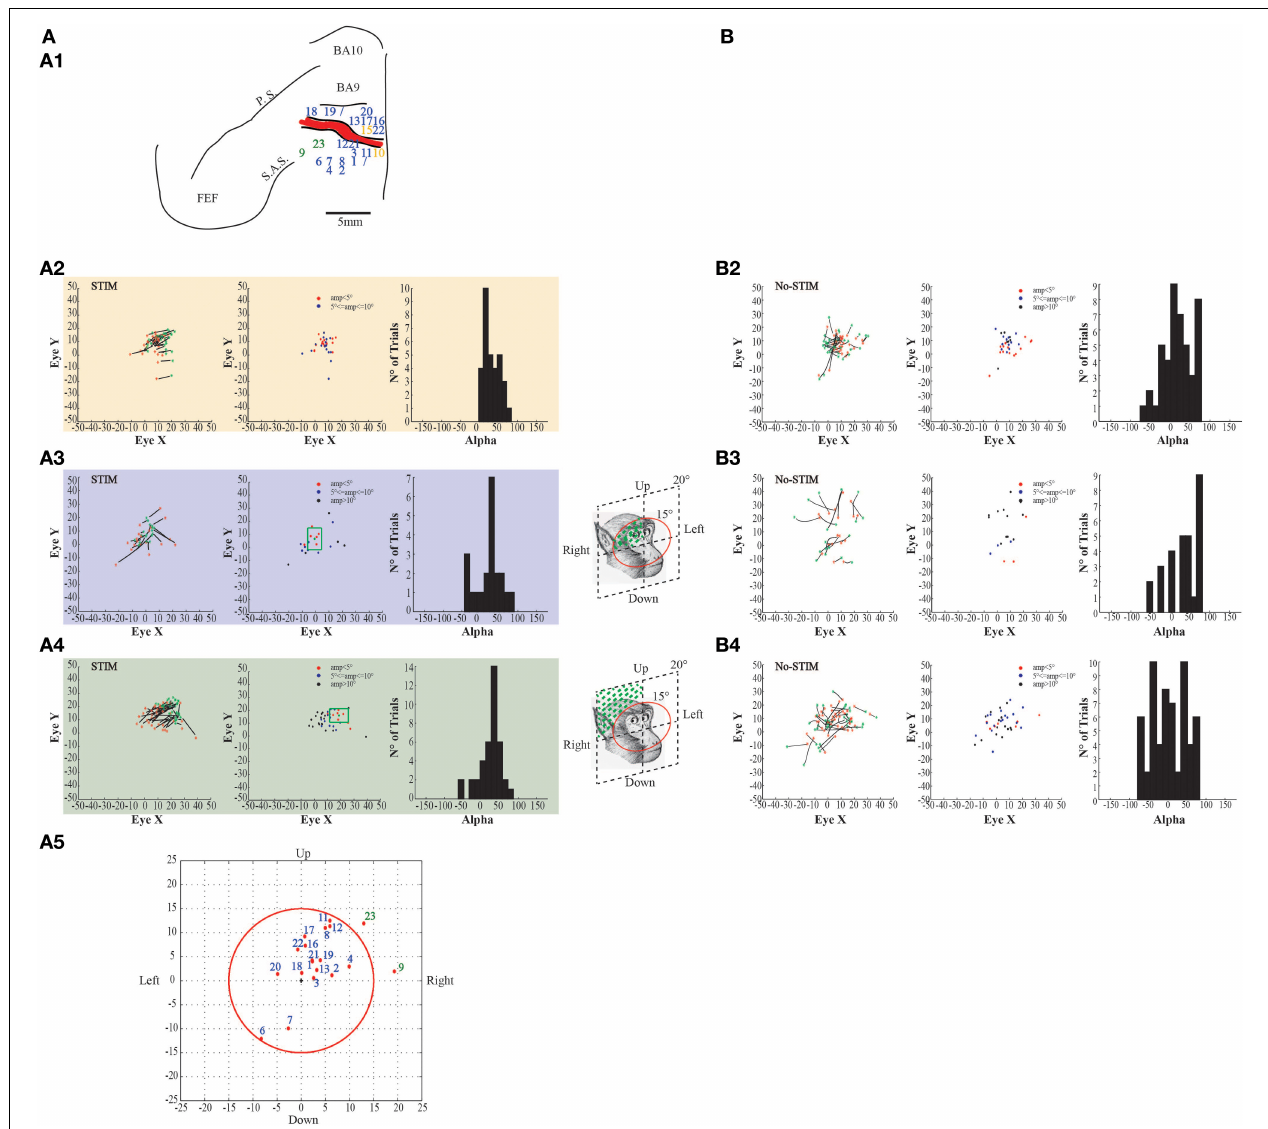
FIGURE 6 | Example of evoked eye movements. (A) The figures show data from monkey L. (A1) Map shows the locations of the electrode penetrations; yellow numbers represent penetrations where fixed-vector saccades were evoked; blue numbers represent penetrations where contralateral goal-directedeyemovementswithendpointsfallingwithin15 ◦ inrespecttothe primaryeyepositionwereevoked; greenfinch numbersrepresentpenetrations where contralateral goal-directed eye movements with endpoints falling beyond 15 ◦ in respect to the primary eye position were evoked. Red thick line represents a superficial vessel which was avoided during the experimental sessions. FEF: Frontal Eye Field; SAS: Superior Arcuate Sulcus; PS: Principalis Sulcus; BA9: Brodmann Area 9; BA10: Brodmann Area 10. (A2) Example of fixed-vector saccades in the core region; red ∗ : starting position; green ∗ : endingposition.Theplotontheleftshowsthedirectionoftheeyemovements. The plot in the middle shows the relationship between starting position and movement amplitude. The plot on the right shows the Alpha values calculated on the basis of the angular coefficient. The values are all positive which indicates that movements go all in the same direction. (A3) Example of contralateral goal-directed eye movements with endpoints falling within 15 ◦ in respect to the primary eye position in the belt region. The plot on the right shows that Alpha values are both positive and negative which indicates that movements have different directions depending by starting position. (A4)